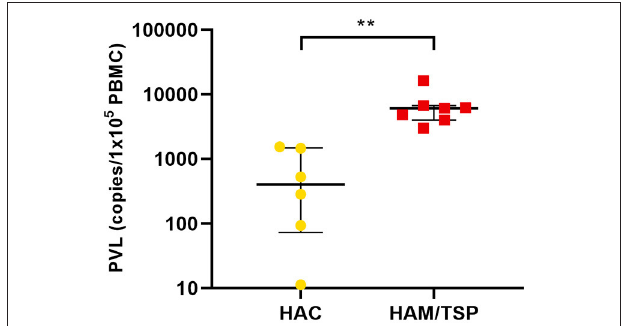
FIGURE 1 | Human T-lymphotropic virus 1 (HTLV-1) proviral load (PVL) in patients with HTLV-1 asymptomatic carriers (HAC) and HTLV-1 associated myelopathy/tropical spastic paraparesis (HAM/TSP). The PVL is expressed by the median value of the estimated number of HTLV-1 provirus copies integrated in 10 5 peripheral blood mononuclear cells (PBMCs) with interquartile range (IQR) for patients with HAC ( n = 6) and HAM/TSP ( n = 7). Statistical analysis was performed by non-parametric Mann–Whitney test: ** p <